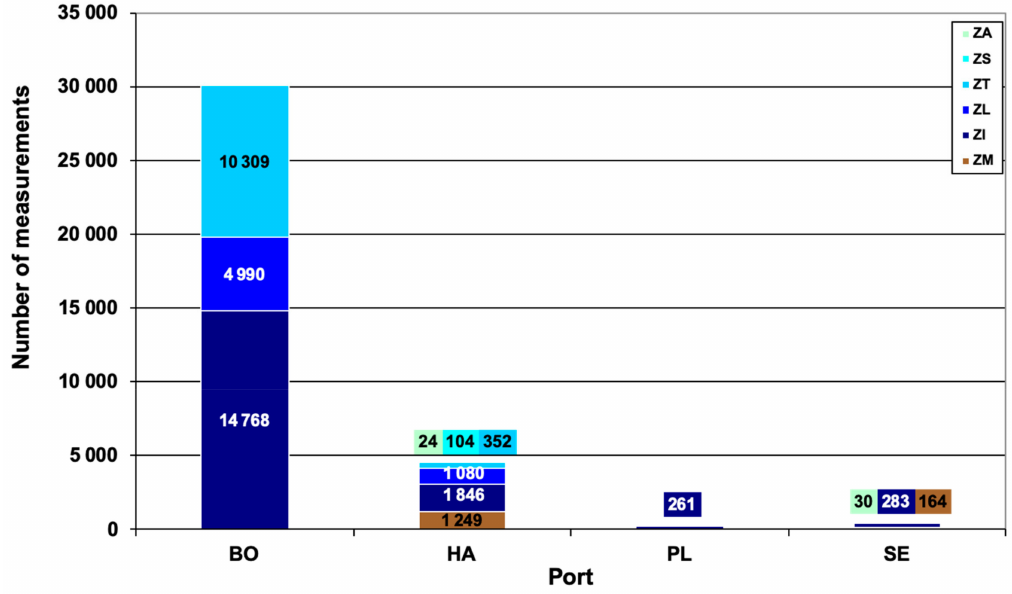
Figure 5. Distribution of data (loss of thickness) in the various exposure zones (ZA: Atmospheric zone; ZS: Splash zone; ZT: Tidal zone; ZL: Low seawater level zone; ZI: Immersion zone; ZM: Mud